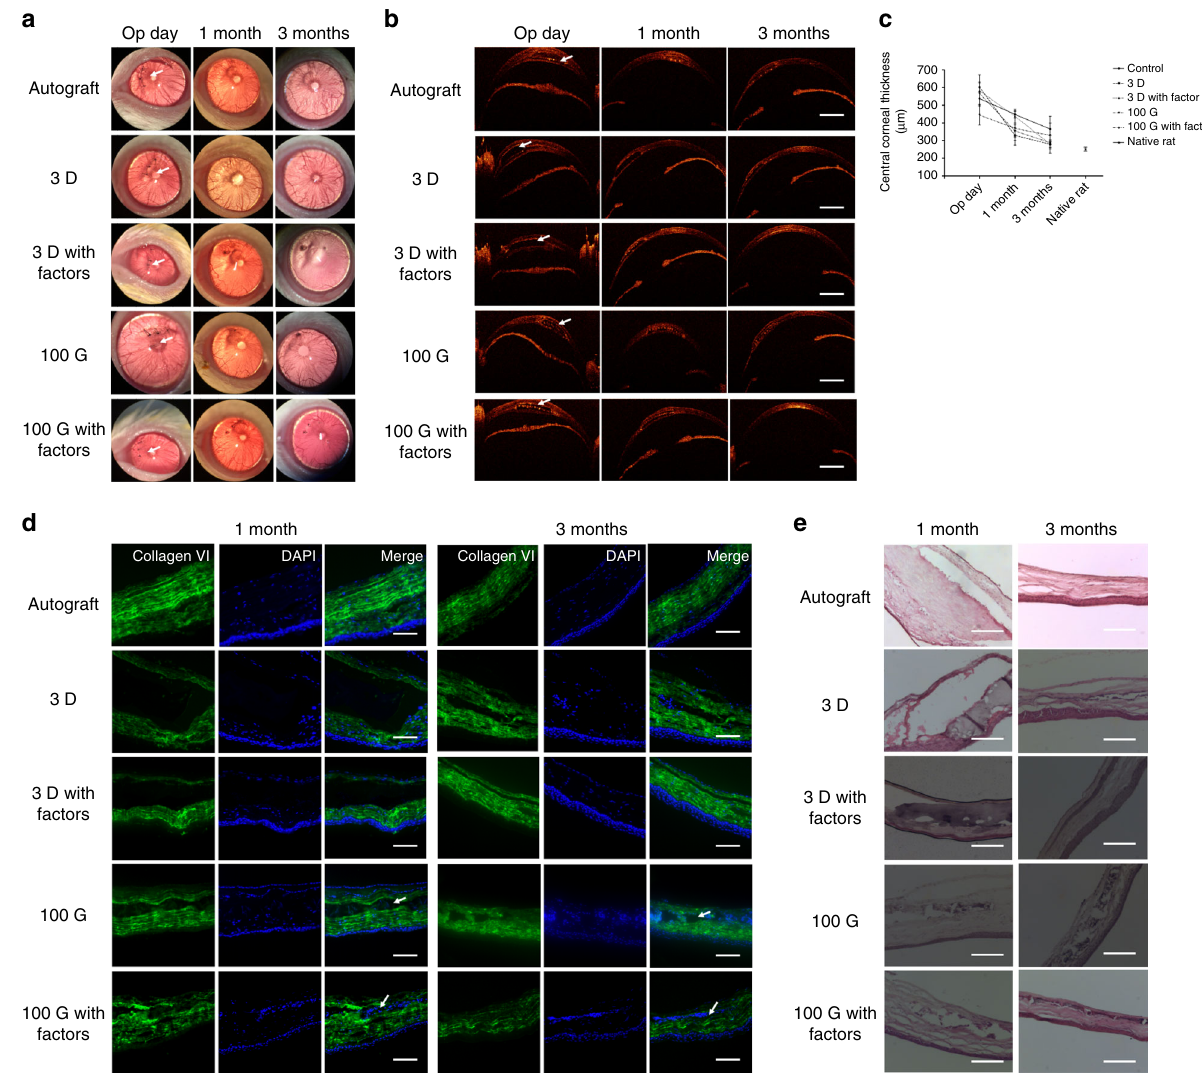
Fig. 4 Fiber hydrogel engraftment and stromal matrix synthesis and regeneration in rat cornea in vivo. a Images taken by slit lamp after operation, 1 and 3 months transplantation of the autograft, 3D GelMA hydrogel with or without chemical factors, 100G fi ber hydrogel with and without factors. The white arrows indicate the position of the grafts. b The OCT images of the same corneas in a postoperatively. The white arrows indicate the position of the grafts. The scale bar is 1000 μ m. c The thickness of the central corneas by measuring corneas ( n = 3, biologically independent samples) in each group and each time point. Data were calculated as mean ± SD. d On 1 and 3 months, frozen sections of the transplanted corneas were immunostained with collagen type VI antibodies (green). In all images, nuclei were co-stained with DAPI (blue), the scale bar is 100 μ m. e H&E staining of the transplanted corneas on 1 and 3 months, the scale bar is 100 μ m. The experiments in a , b , d , and e were repeated three times independently with similar results. Source data are available in the Source Data fi